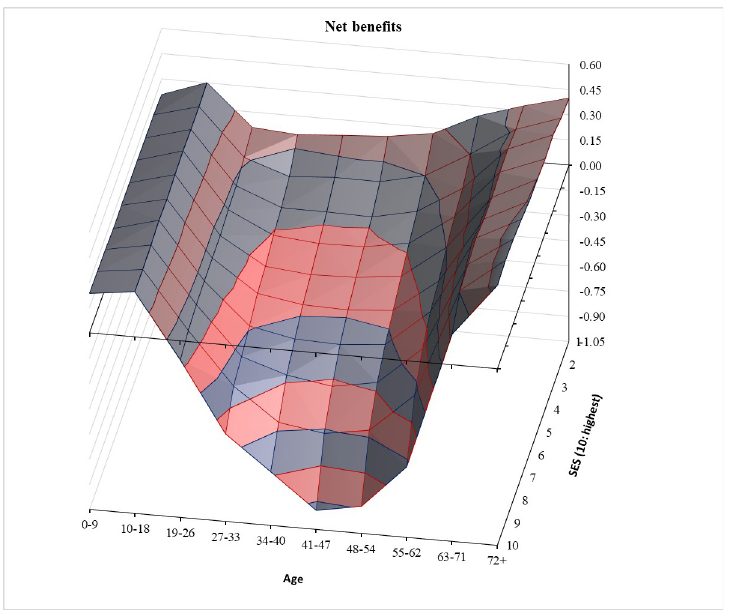
Fig 3. Per capita net welfare benefits (benefits minus taxes) by age and SES in the European Union. Sources and notes as in Fig 1.